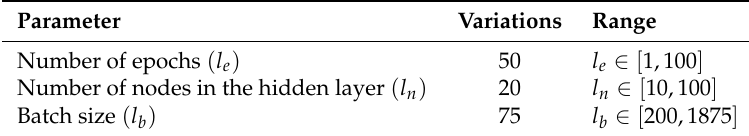
Table 3. Numerical parameters used for chromosome